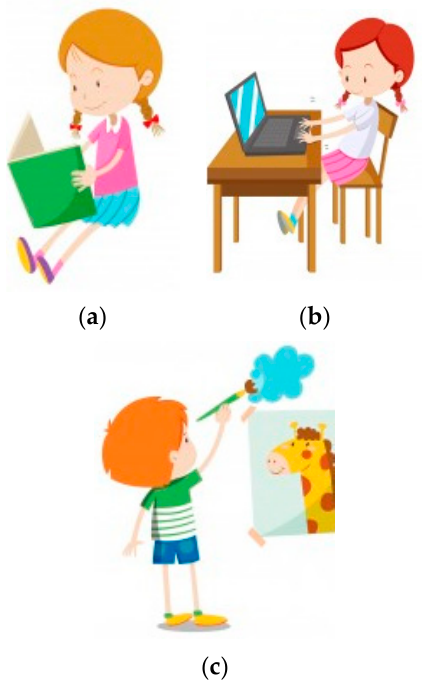
Figure 9. Activity guideline.